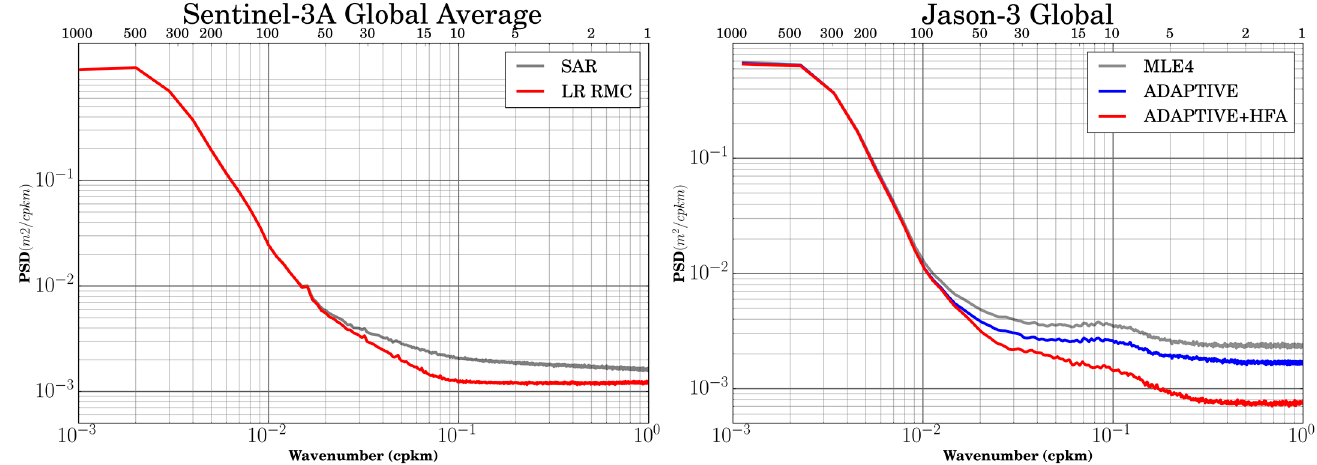
Figure 1. Power spectral density of the SLA along S3A (left) and J3 (right) tracks estimated using different processes. For S3A, conventional SAR (gray) and new LR-RMC (red) processors are presented. For J3, conventional MLE4 (gray), new adaptive (including revised SSB; blue), and new adaptive combined with HFA correction (red) processors are presented. Wavelengths (in km) are given on the top axis.